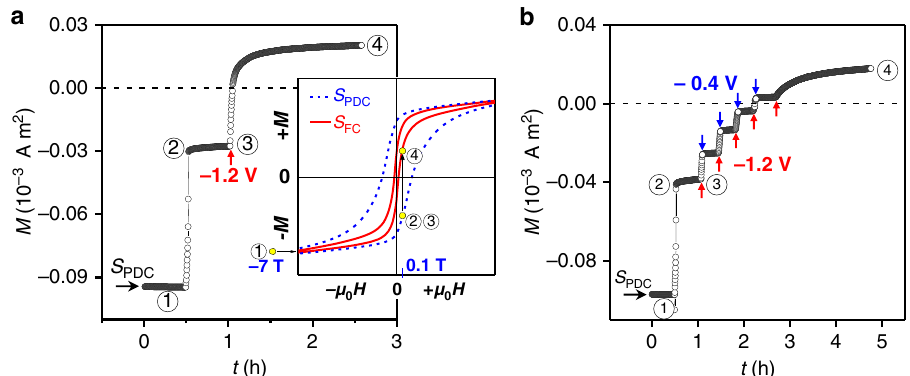
Fig. 3 Voltage-assisted magnetization reversal in SmCo 5 at room temperature. a Time evolution of the magnetization in the S PDC sample with the voltages switched from − 0.4 V to − 1.2 V, showing the voltage-assisted magnetization reversal. Points ① , ② , ③ , and ④ indicate different magnetization states as shown in the inset. b Time evolution of the magnetization in the S PDC sample with the voltages switched repeatedly between − 0.4 V and − 1.2 V, showing the voltage-controlled quick and reversible “ stop and reactivation ” of the magnetization reversal. The red (blue) arrows denote the time points where − 1.2 V ( − 0.4 V) was applied. Here, the same samples as in Fig. 2a were used, with particle sizes of 1 – 10